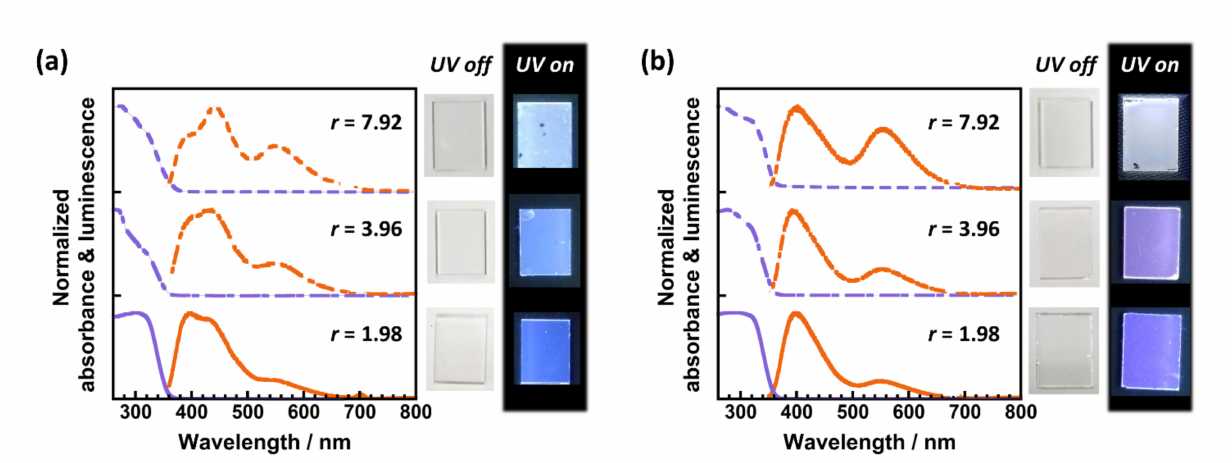
Figure 4. UV − vis absorption and emission spectra of ( a ) ODDC-TfA and ( b ) ODDC-TfA doped with H 2 SO 4 (0.5 ~ 1.0 eq.), which were prepared with variable r values, and photographs of these films under white light (UV off) and UV ( λ = 365 nm) irradiation (UV